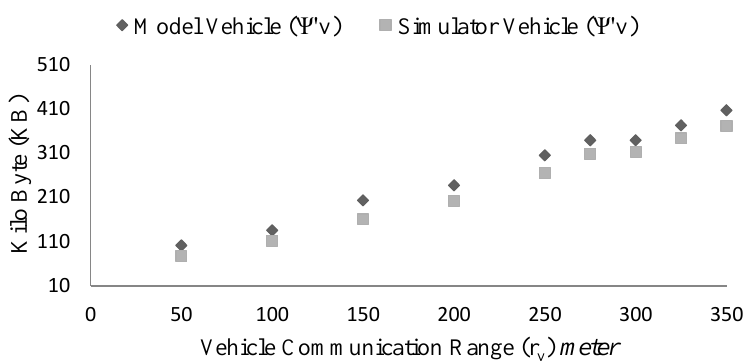
Figure 15. Effect of vehicle communication range ( r in case of simulation and the model.